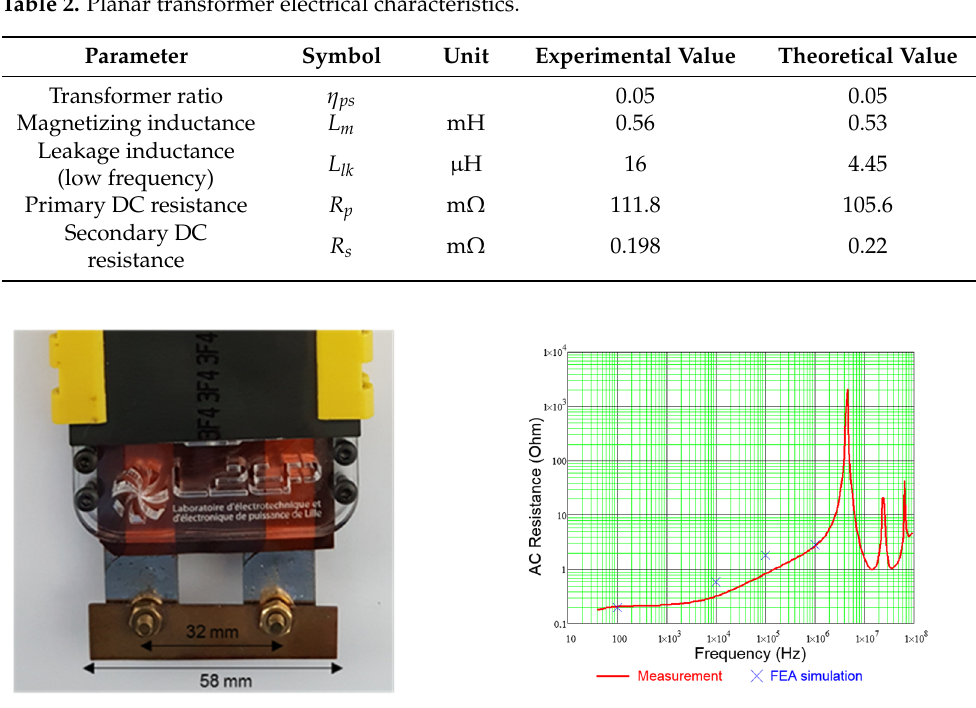
( b ) Figure 11. Thermal characterization—open circuit test: ( a ) temperature distribution; ( b ) voltage, current and power wave- forms.